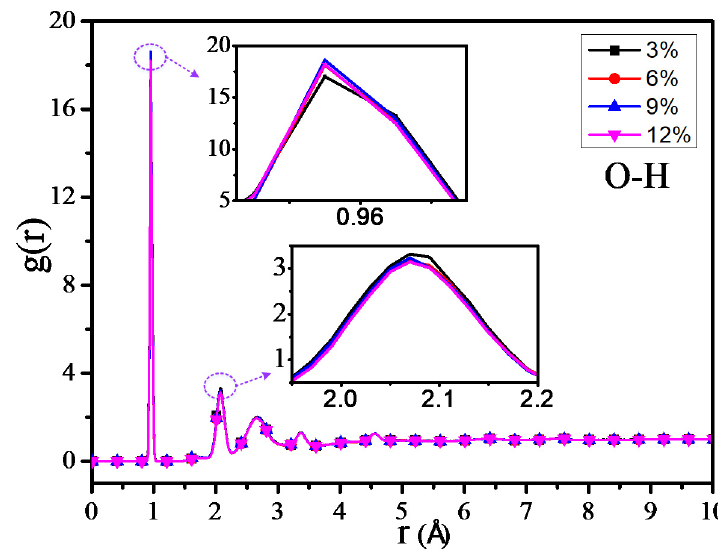
Figure 13. RDF of O–H atoms of different models.